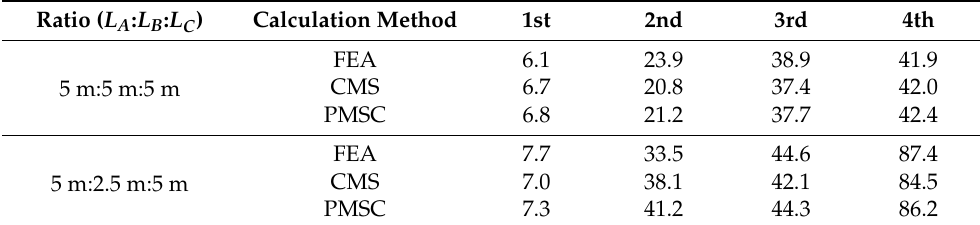
Table 12. Comparison of numerical result